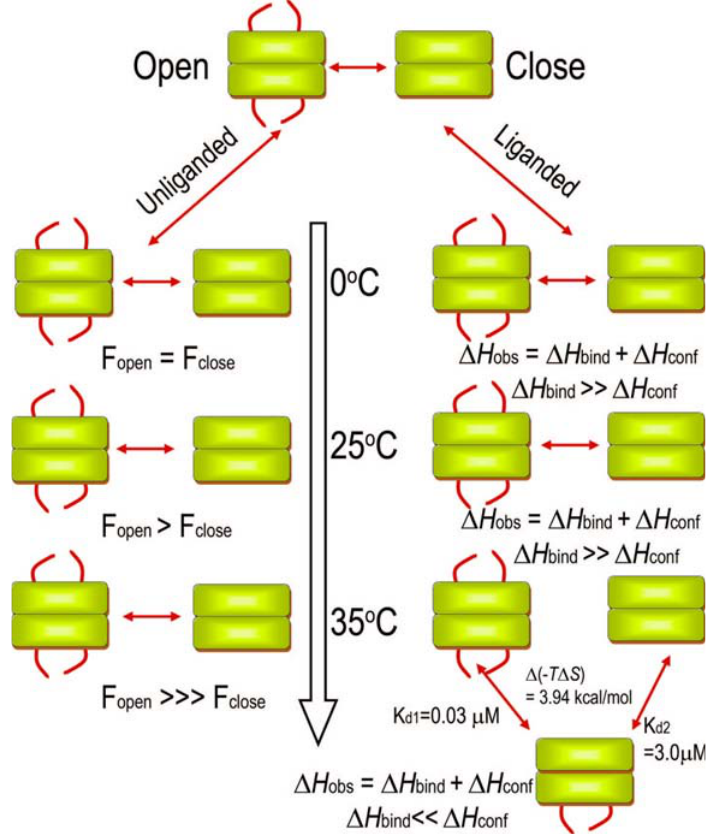
Figure 5. Schematic of the effect of temperature on the dynamics of the unliganded and liganded E1p [60]. In unliganded E1p (no MAP), the loops exist as a conformational equilibrium of open and closed states (Figure 4). This equilibrium gradually shifts in favor of the open conformation up to 25 °C; there is a step transition in favor of the open conformation at 25 °C. During ligand binding > 25 °C, the step “close  open” transition gives rise to a configurational enthalpic term (  H ) of a much higher magnitude, conf resulting from a ligand-induced disorder-to-order transition, which causes progressive ). However, at 35 °C, where the rate of reinforcement of observed enthalpy (  H obs conformational fluctuations of the loop ( k ) and hence the coupled rate of covalent ex substrate addition ( k ) increases, the catalytic rate is regulated by temperature induced 2 anticooperative binding of ligand. At this temperature, binding of the second ligand incurs an entropic penalty, which results in 100-fold weaker affinity for the second molecule of ligand giving rise to the observed negative